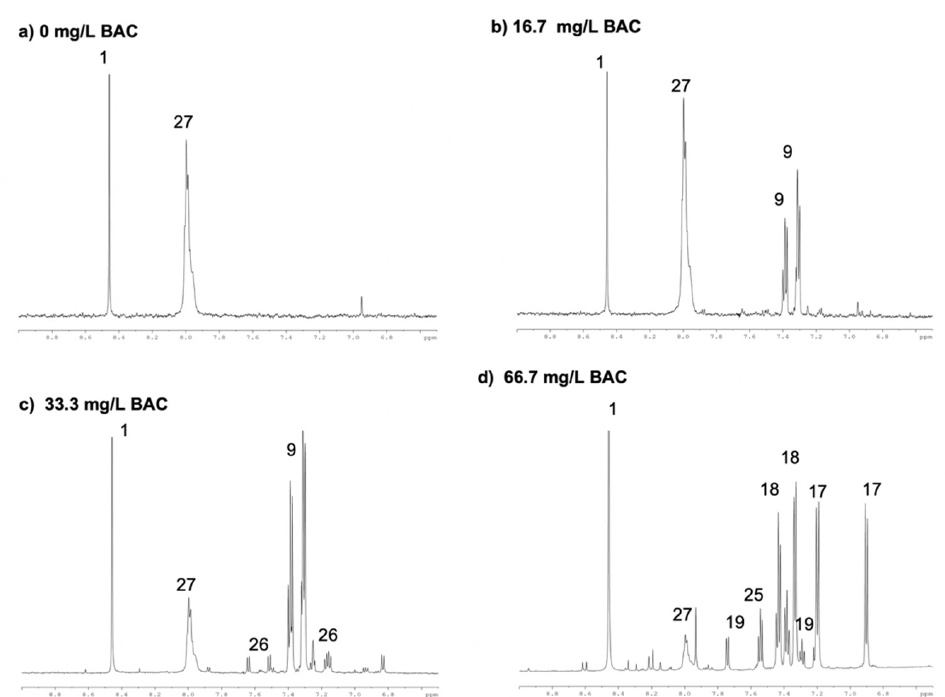
Figure 3. The functionalized alkyl region of the 1 H NMR spectra microcosm samples after 18 days of exposure to BAC for ( a ) 0 mg/L BAC, ( b ) 16.7 mg/L BAC, ( c ) 33.3 mg/L BAC, and ( d ) 66.7 mg/L BAC. Peaks for confirmed structures are numbered and are identified in Table 1.